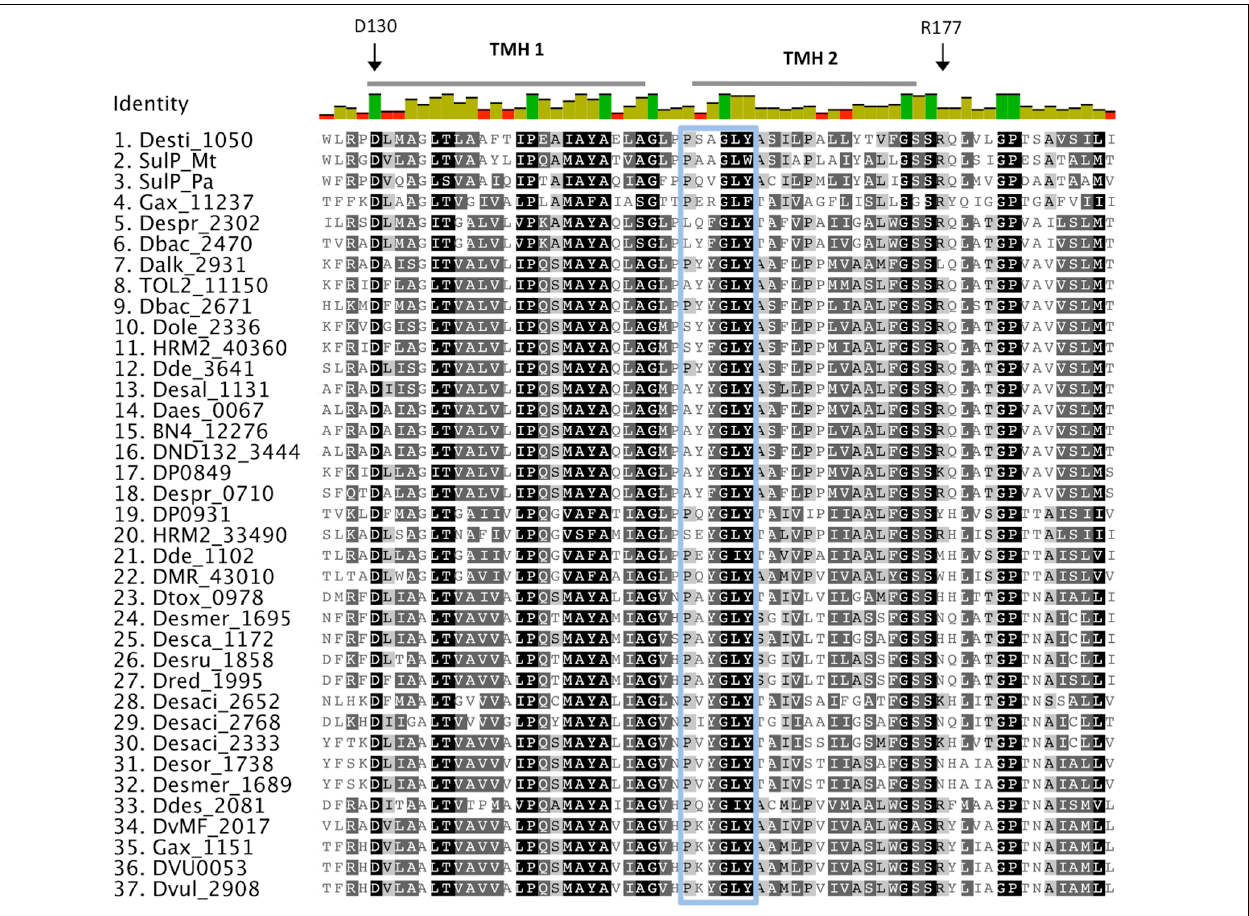
FIGURE 2 | Alignment of putative SulP sulfate transporters. The transporter sequences were selected based on their phylogenetic relationship to the model SulP sequences ( Figure 1 ). Invariant, conserved, and non-conserved residues are indicated by green, olive and red bar chart, respectively. Predicted transmembrane helices (TMH) for SulP_Mt (sulfate transporter) are shown by a gray bar above the sequence. Conserved residues are also highlighted within the alignment by gray shading, the darker the shading the higher conservation. Residues of interest are indicated by black arrows, while the PXYGLY motif is highlighted with a blue